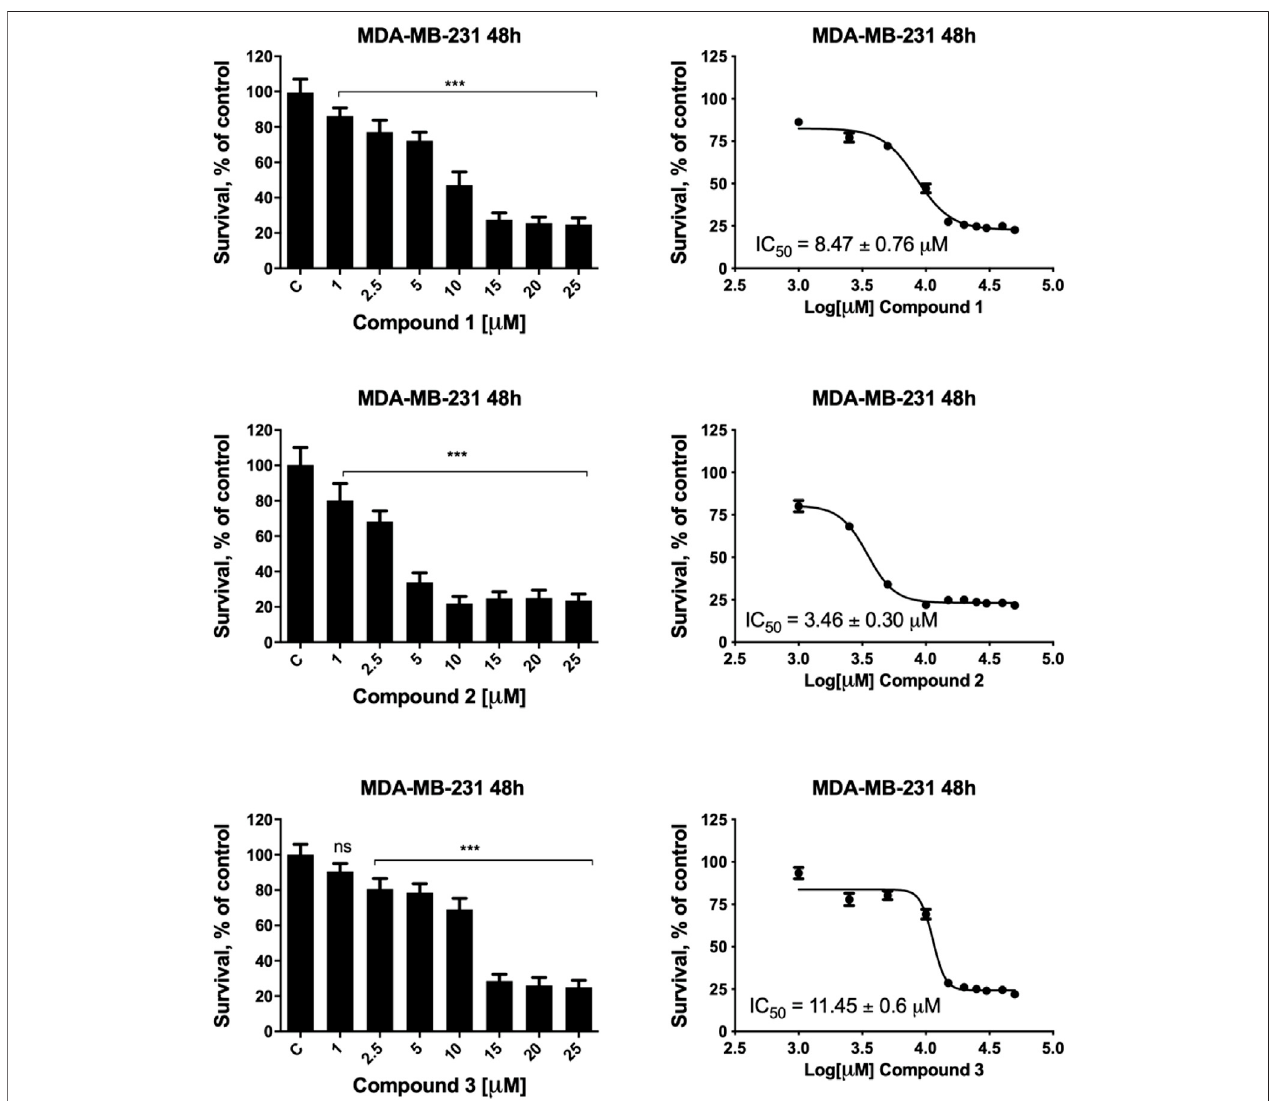
FIGURE 1 | MDA-MB-231 cell viability after treatment with compounds 1 – 3 . MDA-MB-231 cells were incubated in the presence of vehicle or increasing concentrations of compounds 1 – 3 for 48 h, and cell viability was determined by the MTT assay. The results are expressed as percentage of living cells with respect to control (vehicle alone). Columns, mean of three separate experiments, wherein each treatment was repeated in six wells; bars, SD. * p ≤ 0.0332; *** p ≤ 0.0002; **** p ≤ 0.0001,one-way ANOVA followedbyDunnett ’ smultiple comparison test. GI 50 valueswerecalculatedby fi ttingtheconcentration-effectcurvedata obtained inthe three experiments with the sigmoid-E max model using nonlinear regression, weighted by the reciprocal of the square of the predicted effect.